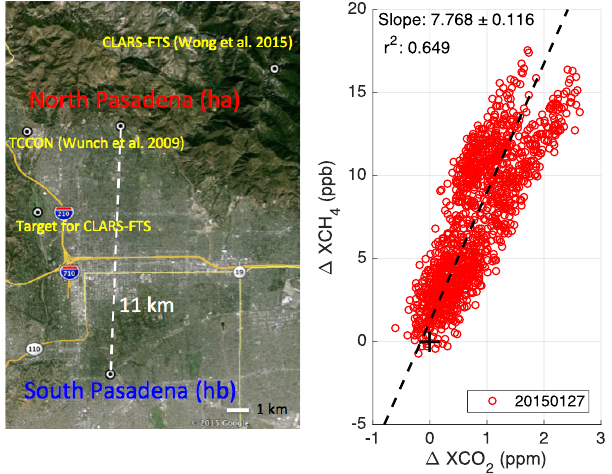
Figure 6. The derived ratio of column differences across Pasadena is consistent with Wunch et al. (2009) using TCCON DMF daily dy- namics and very close to the excess ratio determined in Wong et al. (2015), which compared DMFs from diffuse solar reflectance off a Spectralon plate at Mount Wilson with those from reflected sun- light from West Pasadena. Map provided by Google Earth, Image Landsat, Data SIO, NOAA, US Navy, NGA, and GEBCO.